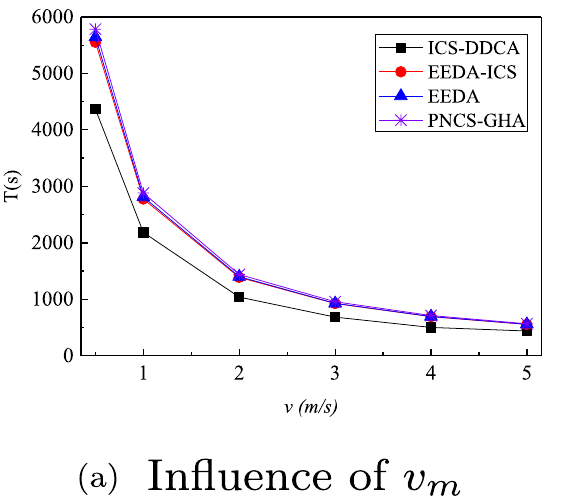
Fig. 8 The effect of the speed of